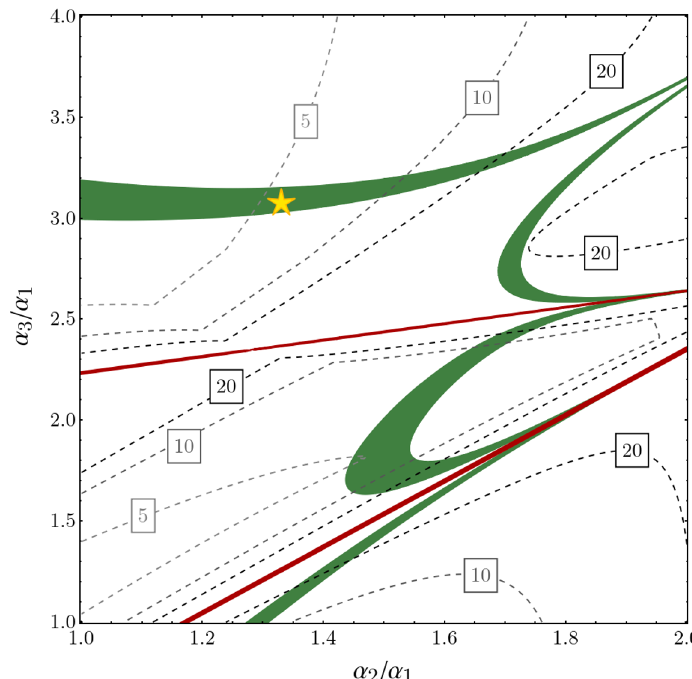
model with large Im τ which, 5